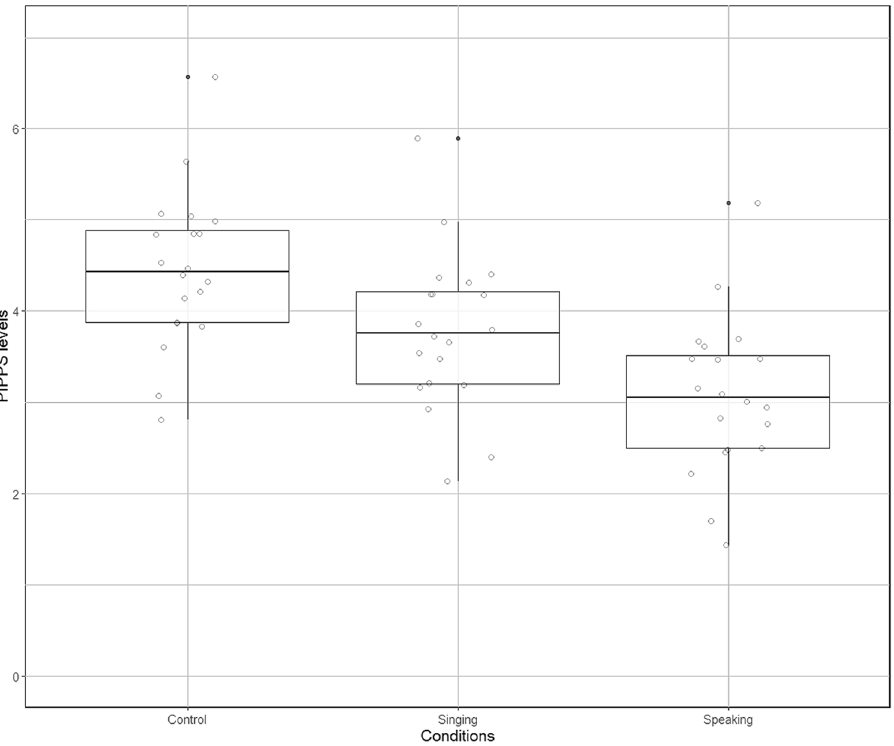
Figure 2. Preterm infants Pain Profile scores presentation in the Control, Singing and Speaking conditions during painful procedures.